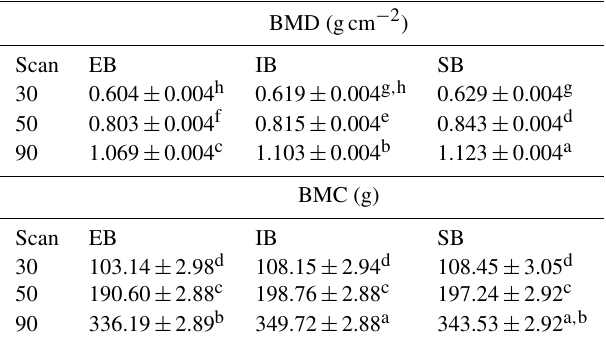
Table 6. BMD and BMC depending on sex and scan time (LSM ± SEE) – average of nine measurements (body regions). Dif- ferent superscripts within trait characterize significant differences ( p< 0 .